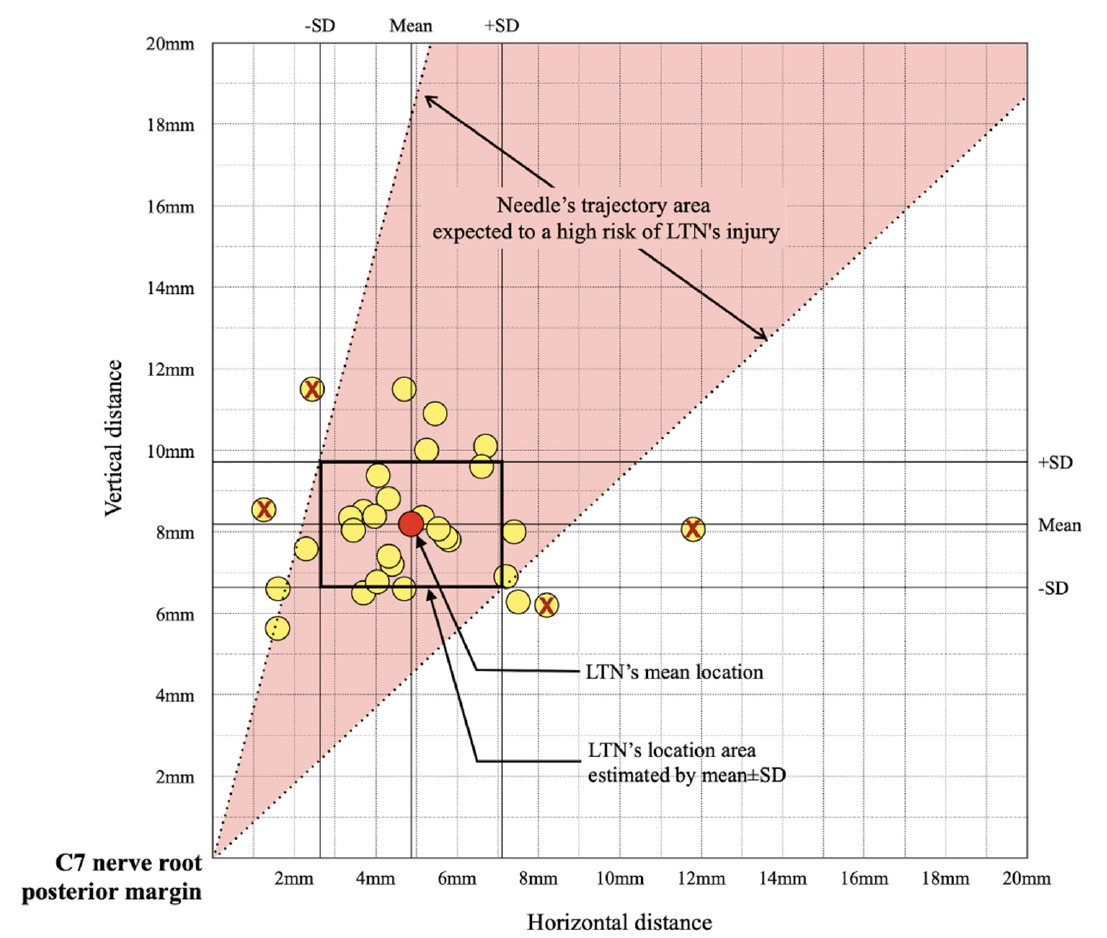
Figure 3. The schematic diagram reveals the long thoracic nerve (LTN)‘s location of each case. The C7 nerve root’s posterior margin is the origin, the x -axis is the horizontal distance, and the y -axis is the vertical distance. The LTN marked as 🅧 indicates that it was outside the risk area in the simulated risk analysis. The LTN’s mean location and locational area estimated by the mean ± standard deviation (SD) are presented. The painted area indicates that the needle’s trajectory is expected to be associated with a high risk of LTN injury.